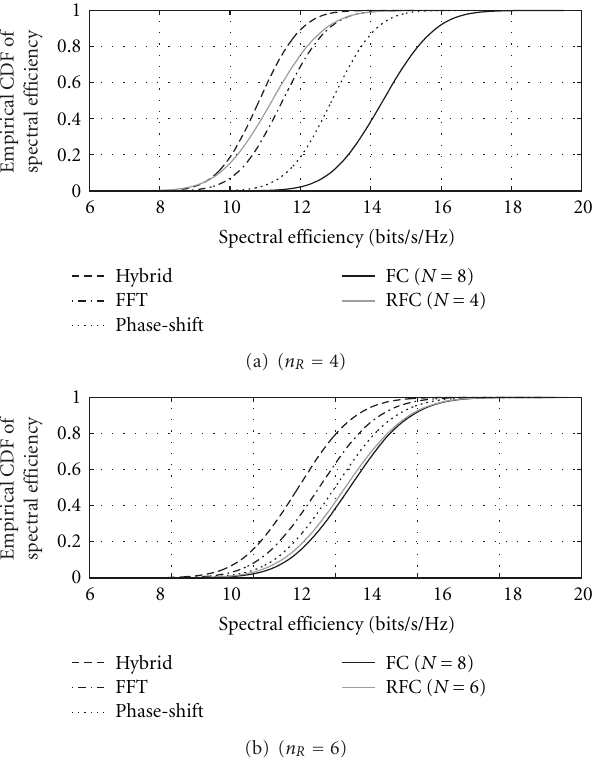
Figure 10: Empirical CDF of the spectral e ffi ciency of a compact MIMO system with AS. M = 5 and N =